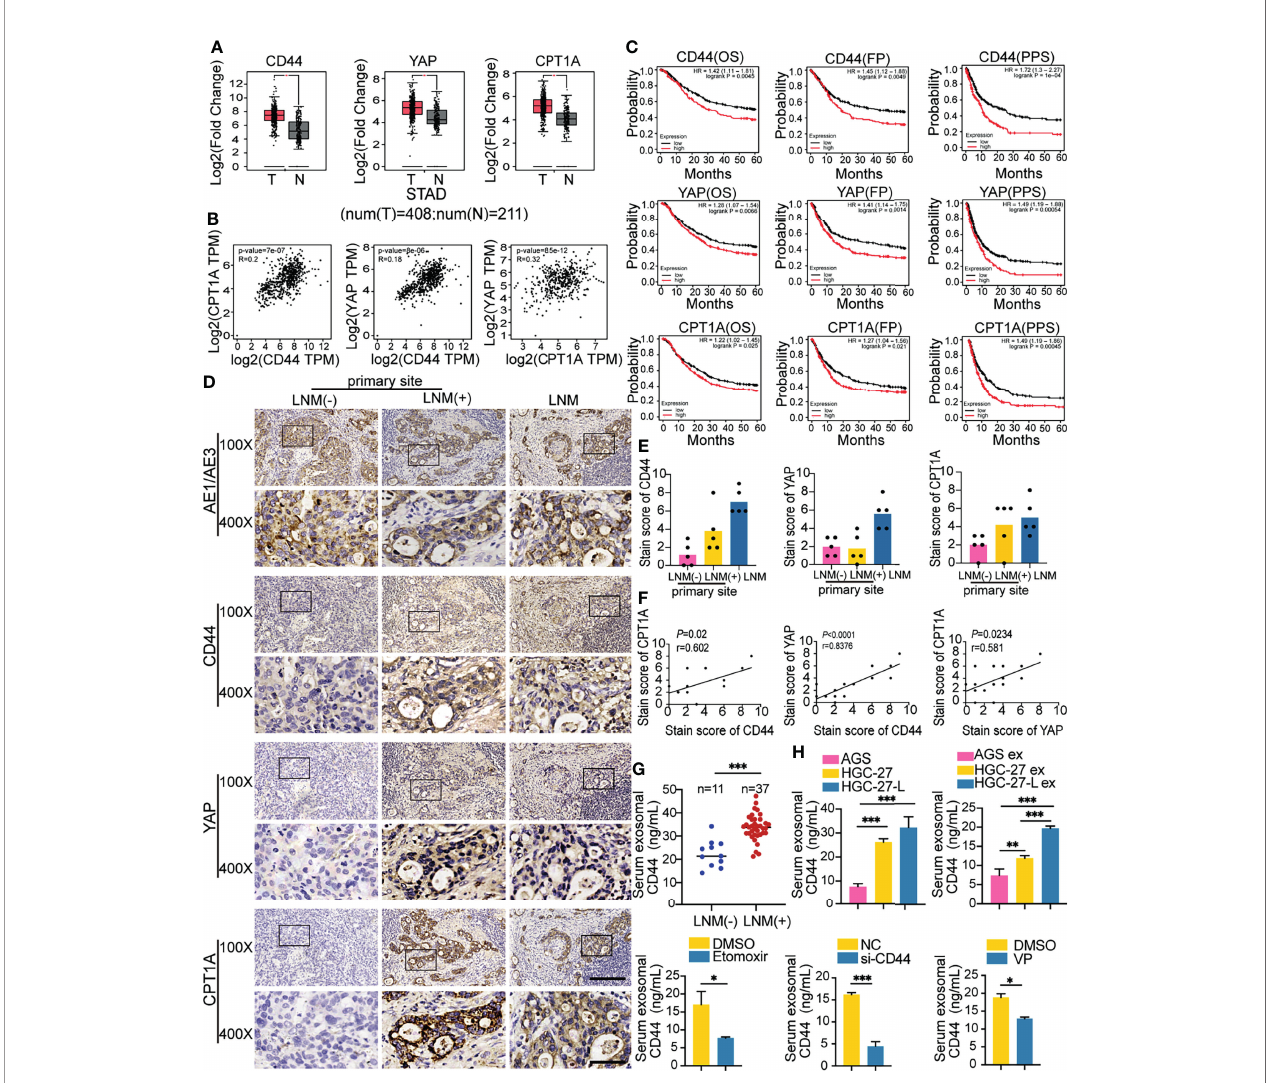
FIGURE 6 | Clinical signi fi cance of CD44/YAP/CPT1A in GC tissues and the association of serum exosomal CD44 with LNM (A, B) GEPIA analysis of CD44, YAP and CPT1A expression between 408 GC tissues and 211 normal tissues (A) and their expression correlation (B) ; (C) Kaplan Meier plotter analysis of CD44, YAP and CPT1A association with a fi ve-year survival of GC patients, including overall survival (OS), fi rst-progression survival (FP) and post-progression survival (PPS); (D – F) IHC analysis of CD44, YAP and CPT1A protein levels in primary GC tissues from GC patients with or without LNM and corresponding metastatic LNs. (D) Representative images; (E) Comparison of CD44, YAP and CPT1A staining scores; (F) Correlation of staining scores among CD44, YAP and CPT1A; (G) Comparison of serum exosomal CD44 concentration between GC patients with or without LNM; (H) Serum exosomal CD44 concentration detection in different groups of tumor-bearing animal models. ex, exosomes. * P < 0.05; ** P < 0.01; *** P <